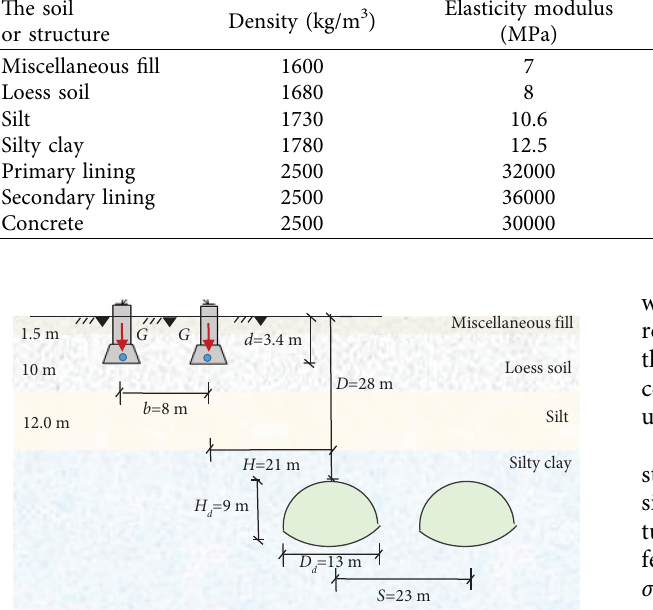
Figure 5: Schematic diagram of stratum distribution and location relationship between new tunnel and tower